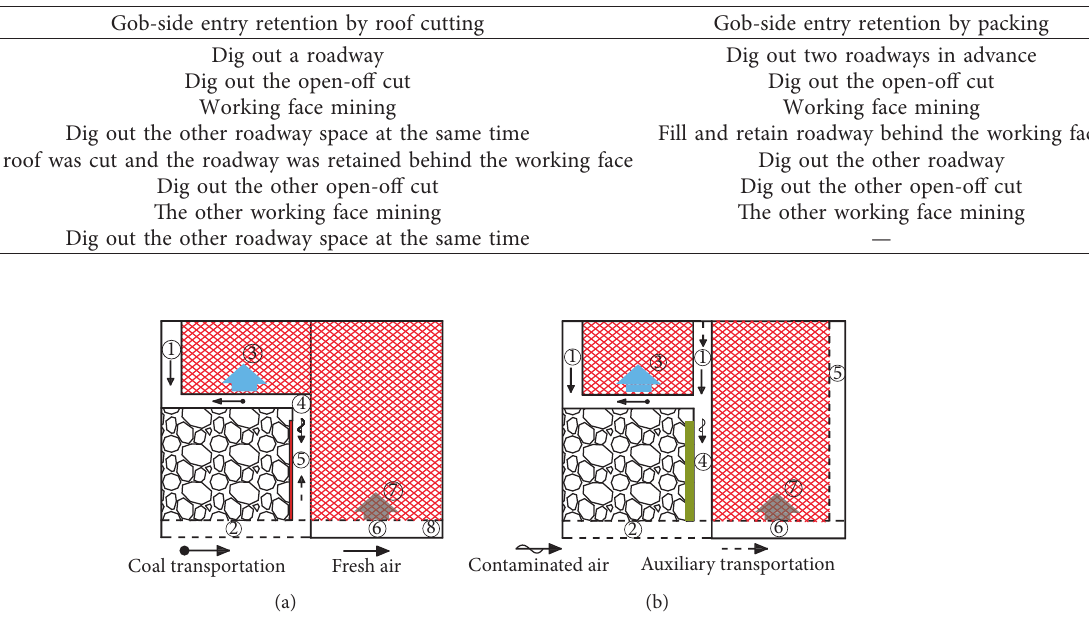
Figure 1: Location of S1201-II working face. Table 1: The difference of gob-side entry retention by roof cutting and by packing.